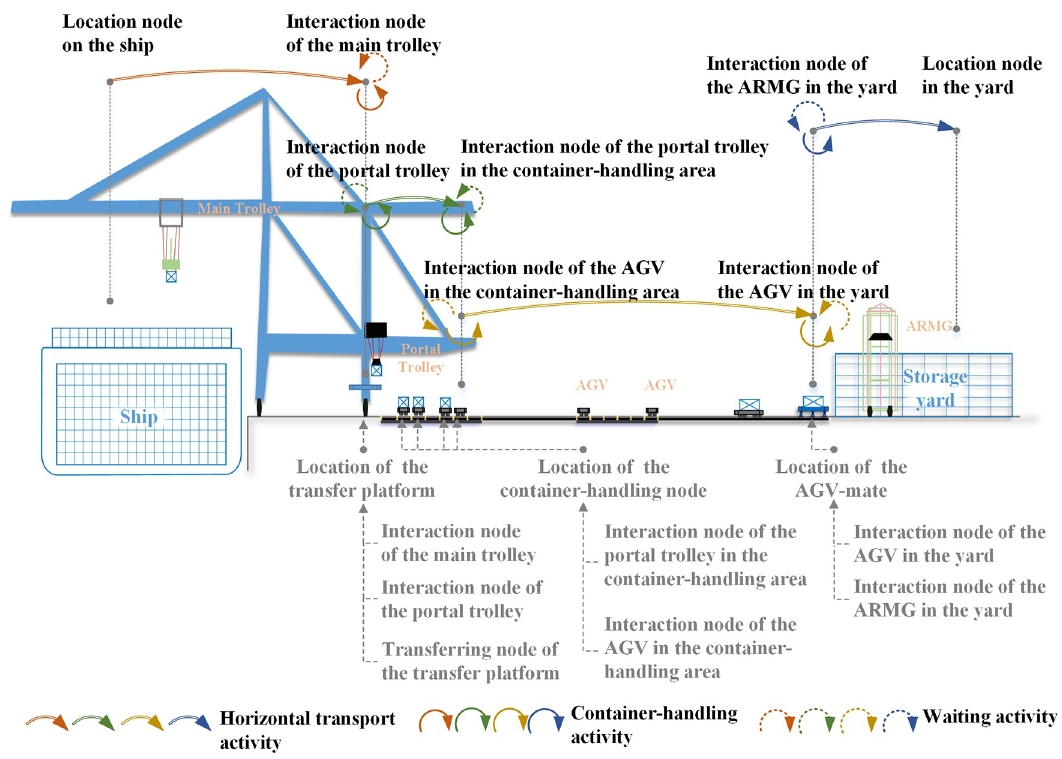
Fig 4. Equipment activities that occur on six types of interaction